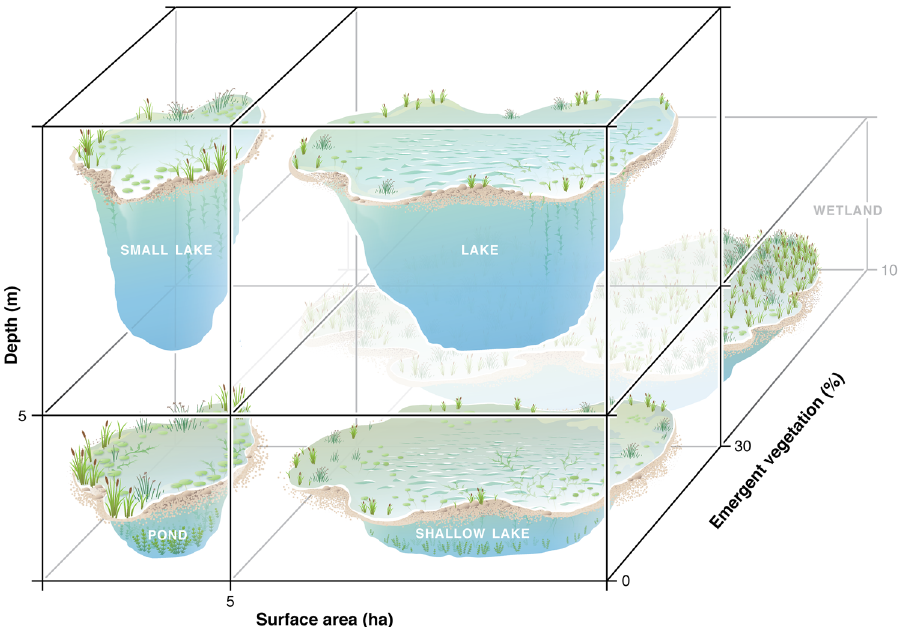
Figure 8. Conceptual model to define lentic waterbodies based on three different criteria (depth, surface area, and emergent vegetation). Boundaries for all three axes come from our analysis and are informed by existing pond, lake, and wetland definitions. Figure by Visualizing